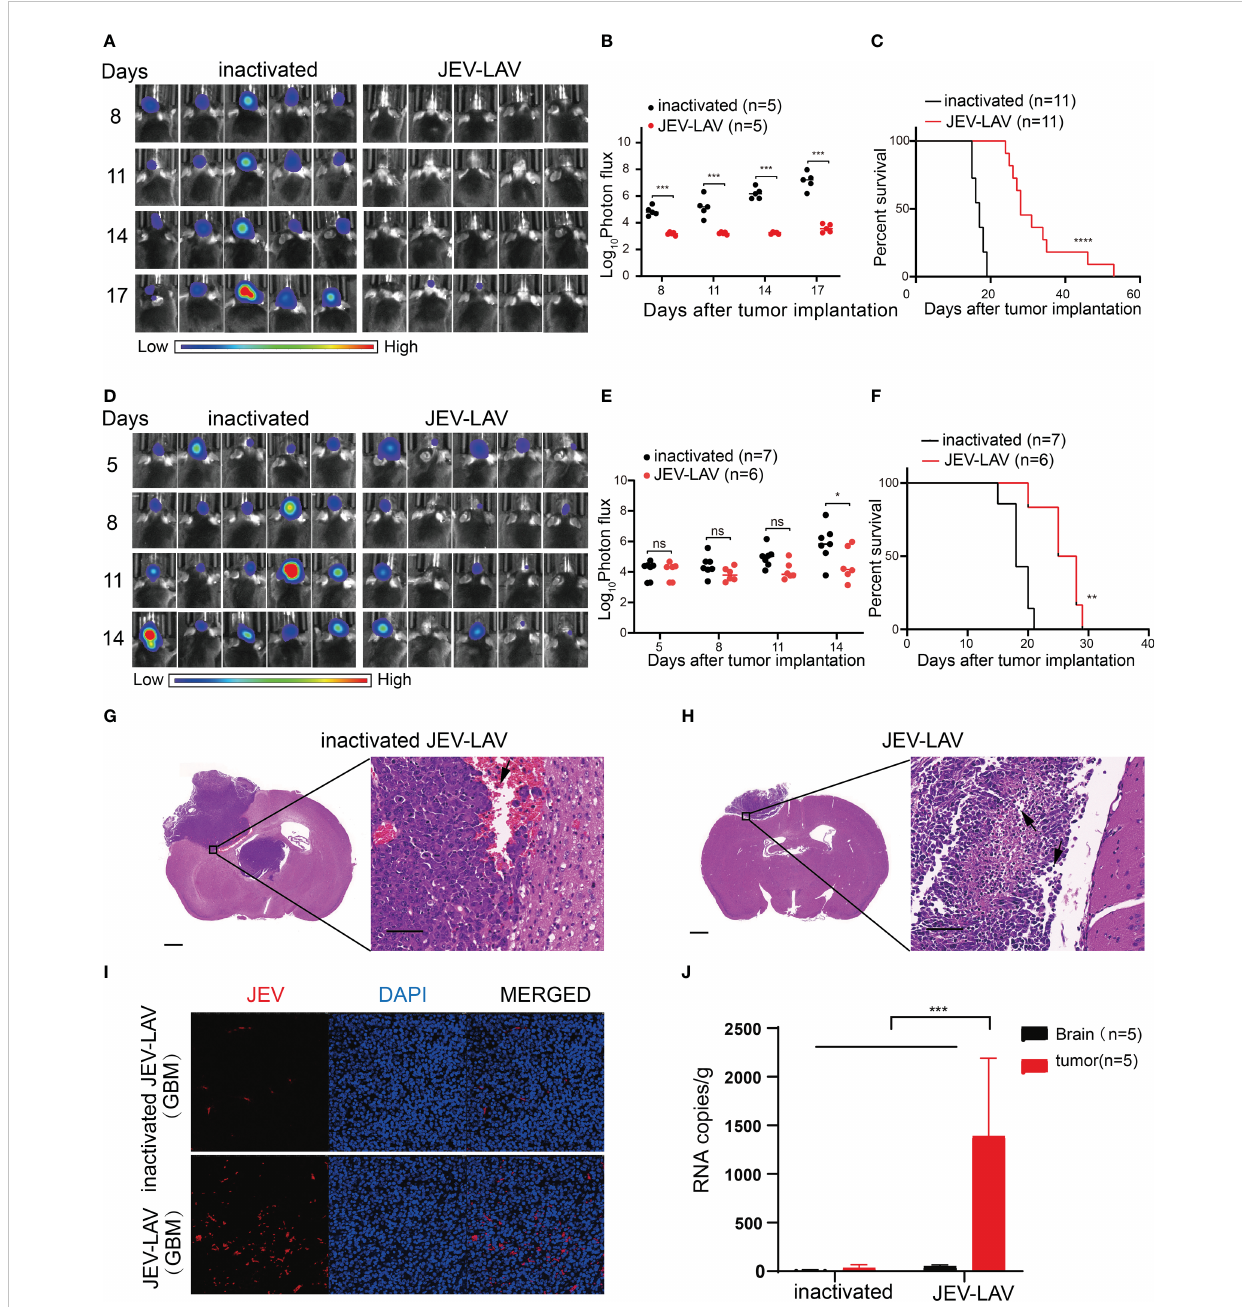
FIGURE 3 JEV-LAV inhibits the growth of GBM in vivo and prolongs the survival of tumor-bearing mice. (A – C) C57BL/6J mice were intracranially implanted with 1 × 10 5 GL261-luc cells infected with 1 × 10 6 PFU JEV-LAV for 2 h or HI-JEV-LAV (control). (A) Individual tumor growth via bioluminescence at the indicated times. (B) Quanti fi cation of total photon fl ux from each animal. (C) Survival. (D – J) C57BL/6J mice were intracranially implanted with 1 × 10 5 GL261-luc cells and injected intratumorally with 1.6 × 10 6 PFU JEV-LAV or HI-JEV-LAV after 5 days. (D) Individual tumor growth via bioluminescence at the indicated time points. (E) Quanti fi cation of total photon fl ux from each animal. (F) Survival. (G, H) Representative pictures of hematoxylin and eosin staining of coronal brain slices on day 12 after JEV-LAV treatment. Scale bars = 2000 m m (left panel) and 50 m m (right panel). The immune cells in fi ltrating into the tumor are indicated by arrows. (I) Representative pictures of immuno fl uorescent staining of the glioma paraf fi n sections for JEV NS3 protein (red) and DAPI (blue). (J) Distribution of JEV-LAV in the brain and tumor of mice after 5 days of intracerebral administration. *P<0.05, **P<0.01, ***P<0.001,****p<0.0001, ns no statistical signi fi